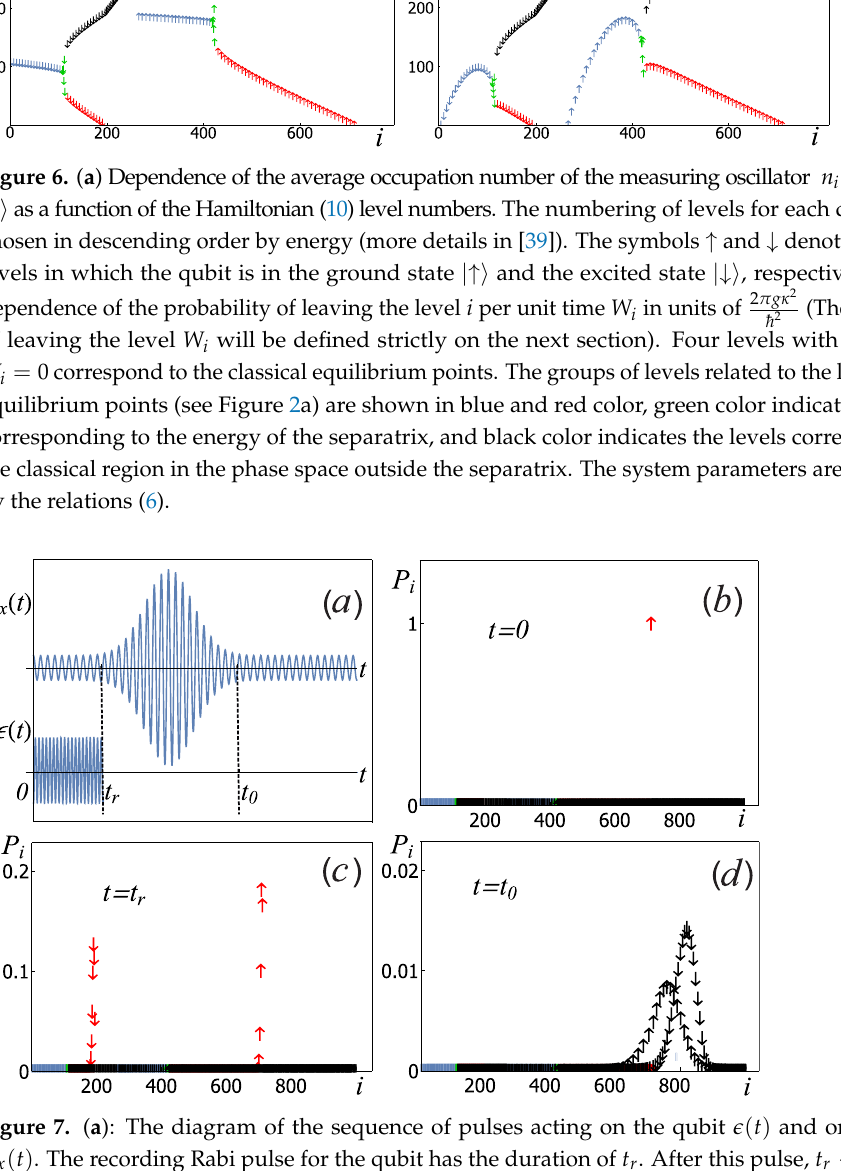
Figure 7. ( a ): The diagram of the sequence of pulses acting on the qubit (cid:101) ( t ) and on the sensor ˜ I ex ( t ) . The recording Rabi pulse for the qubit has the duration of t r . After this pulse, t r < t < t 0 , the modulating pulse is applied to the sensor. The values of the diagonal elements of the system density matrix P i , depending on the level number i , under the sequential action of the π /2 pulse on the qubit and the pulse current on the oscillator at different times: ( b ) at the initial moment of time t = 0, ( c ) at the end of the Rabi pulse t = t r , ( d ) after initialization of the measuring oscillator t = t 0 . The use of colored arrows is the same as in Figure 6a,b. Numerical calculations are made for (cid:101) 0 = 1.2¯ h ω 0 , (cid:113) ¯ h = 3.9¯ h ω = 5.5 1 I p , other system parameters are determined by the relations 0 , and τ ω 0 4 ω 0 C